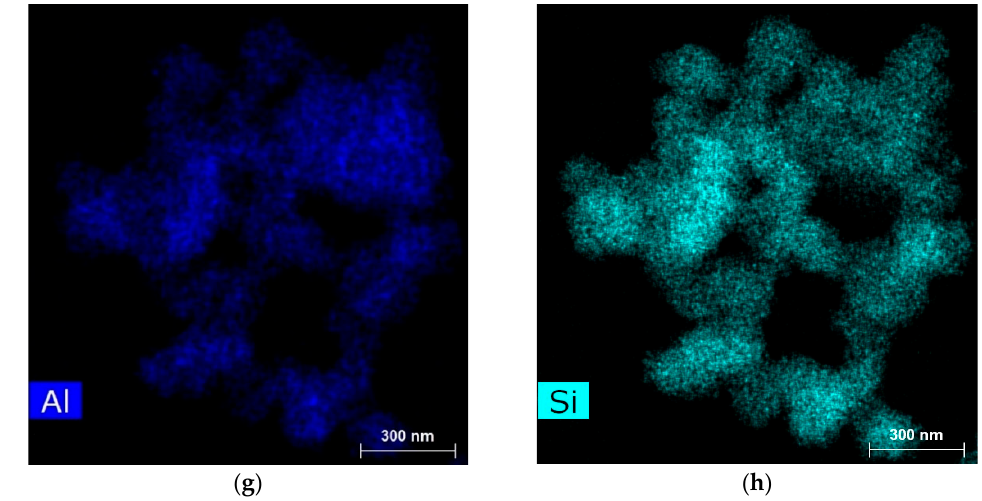
Figure 7. ( a ) TEM micrograph and distribution maps of NiWS-HY(1%) elements ( b ) Ni-W, ( c ) Ni, ( d ) W, ( e ) O, ( f ) S, ( g ) Al, ( h ) Si obtained in situ in standard conditions.